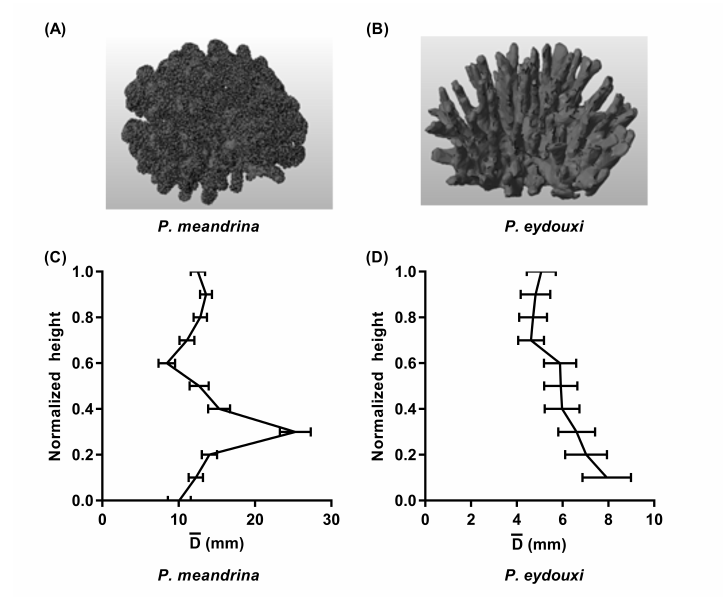
Figure 3. ( A , B ) Rendered stereolithography files of the P. meandrina and P. eydouxi colony geometries used in the simulations. ( C , D ) Mean branch diameter at normalized height from the base of the Pocillopora colonies. Horizontal bars indicate the